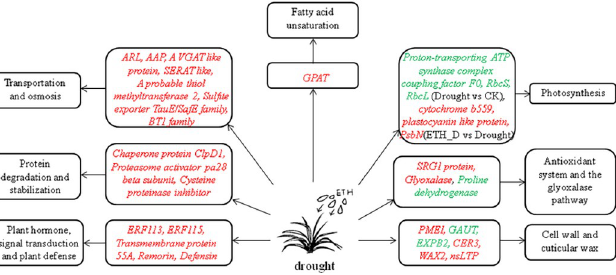
Fig 9. The mechanism for how ethephon regulates drought response and improves drought tolerance of Kentucky bluegrass. The gene in red indicates that the gene is up-regulated and the gene in green indicates that the gene is